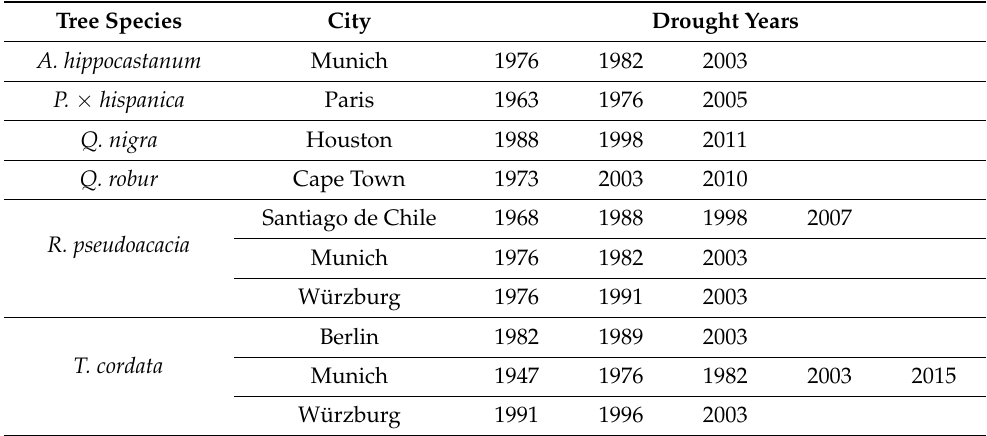
Table 4. Selected drought years of the seven cities for the analysis of the reaction of the annual diameter increment to drought by using superposed epoch analysis (SEA).